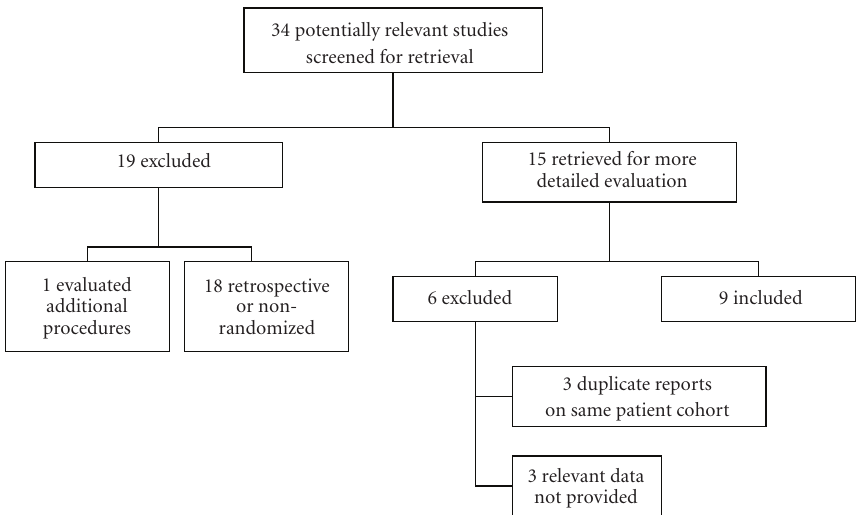
Figure 1: Flow diagram showing the number of studies initially identified and the reasons for study